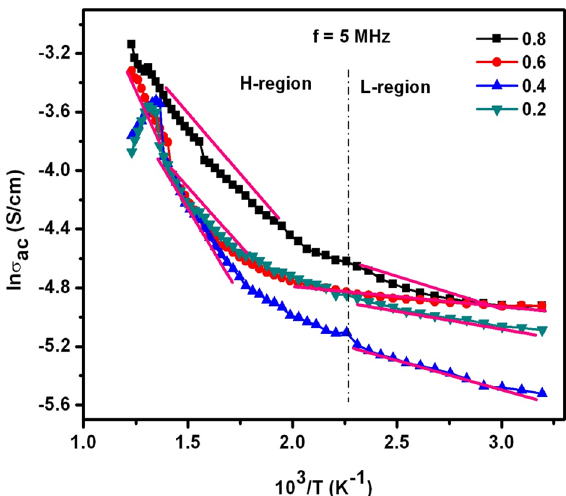
Figure 14. lnσ ac versus 10 3 /T plots of SLFO